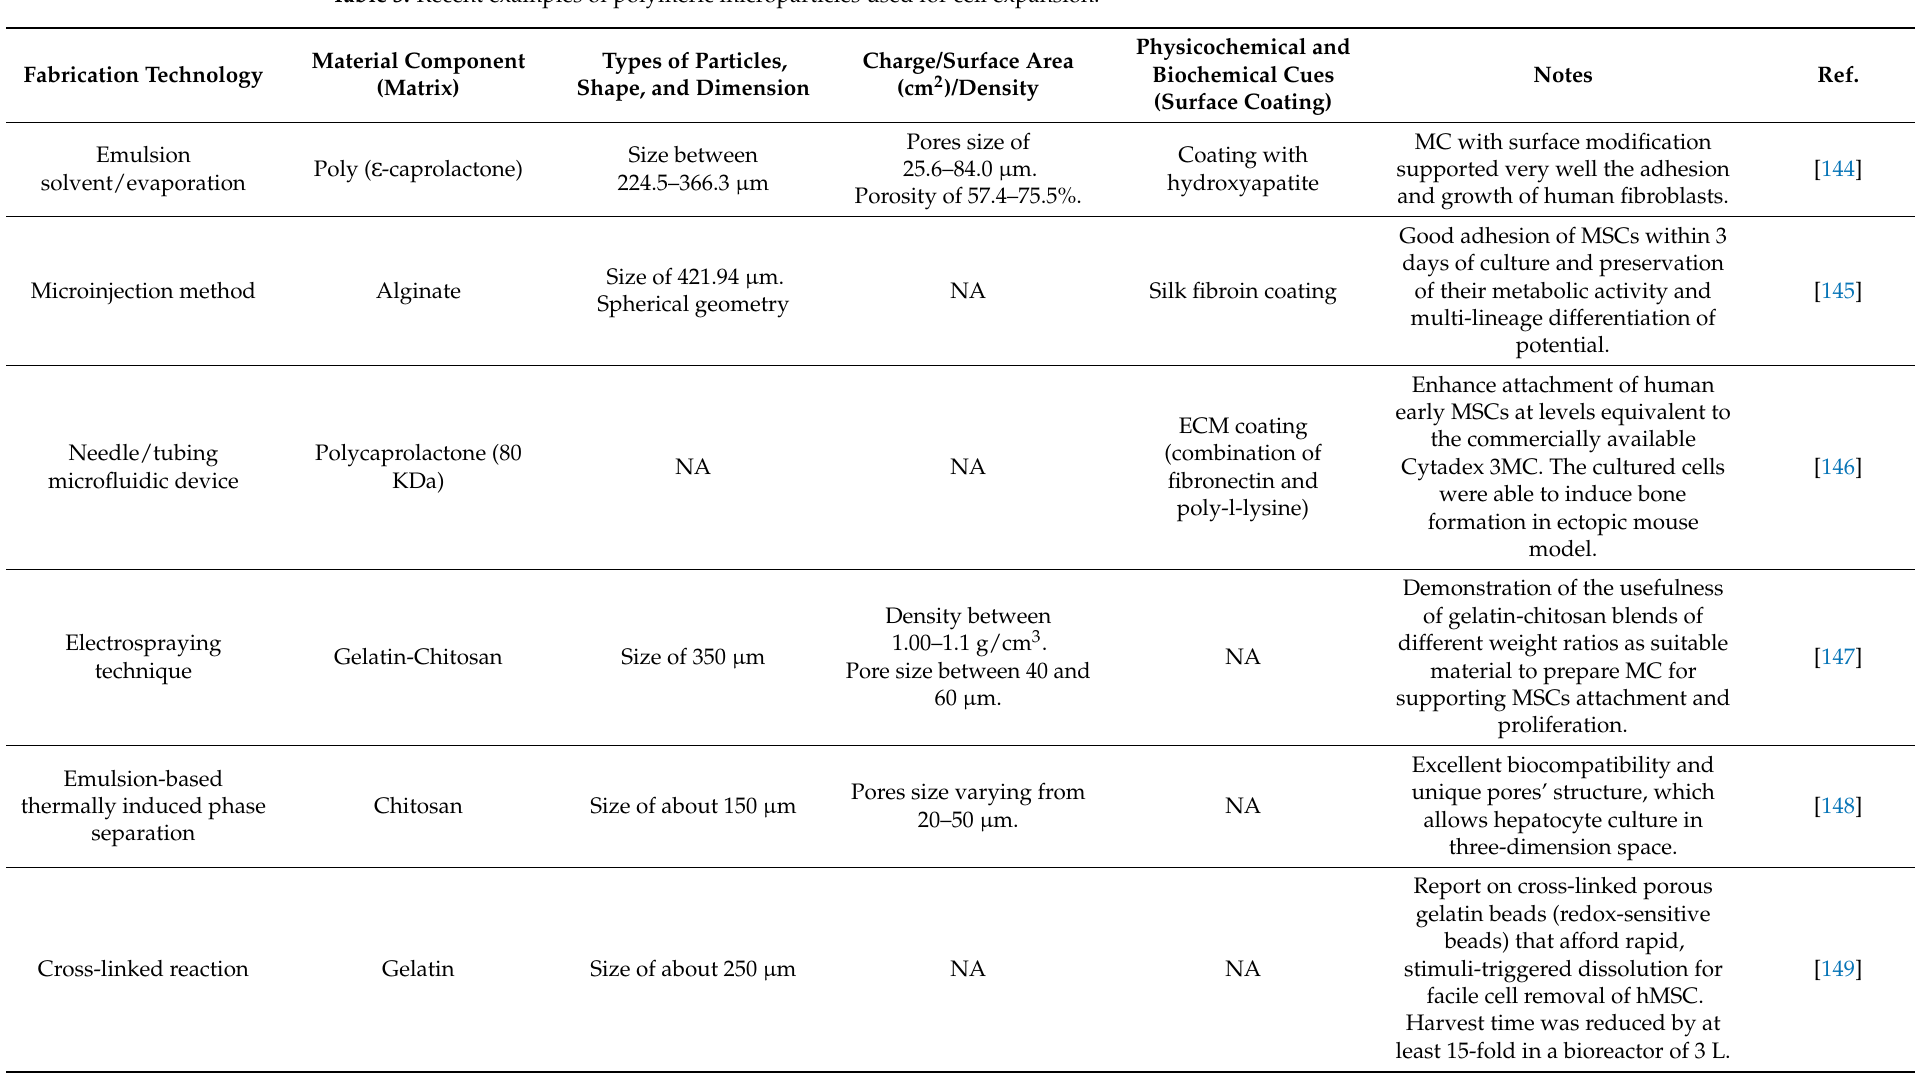
Table 3. Recent examples of polymeric microparticles used for cell